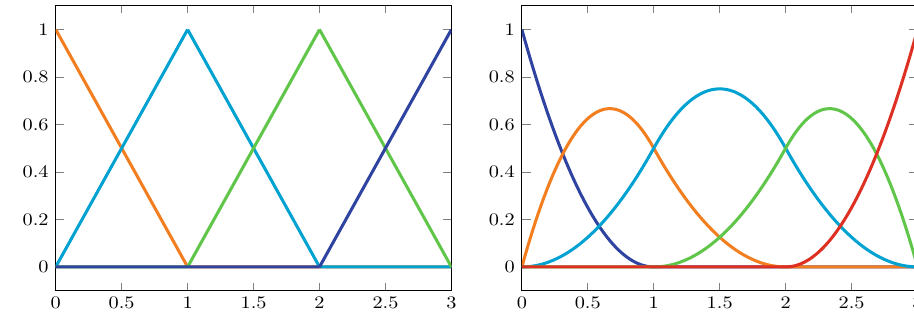
Fig. 1 Linear (left) and quadratic (right) B-spline basis functions based on the knot vectors Ξ 1 = { 0,0,1,2,3,3 } and Ξ 2 = { 0,0,0,1,2,3,3,3 } ,